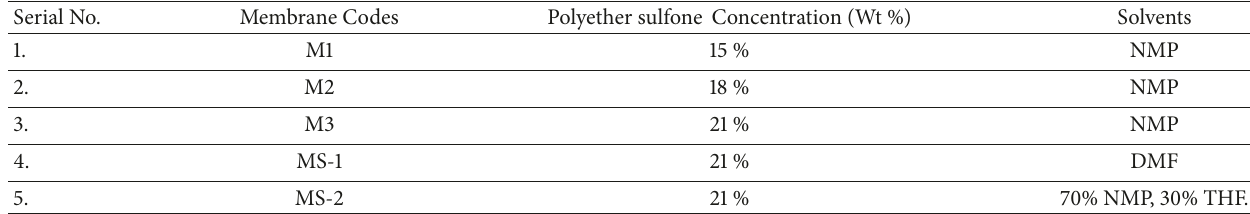
Table 1: Composition of prepared membranes.